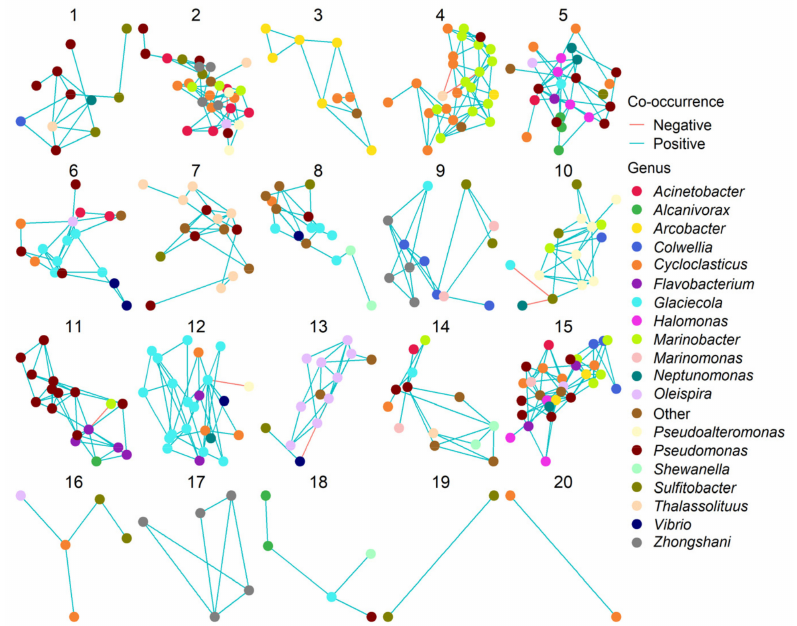
Figure 5. Network modules based on clustering of a SPIEC-EASI co-occurrence network formed of ASVs from bacterial genera associated with hydrocarbon degradation. Each point represents a single ASV, which are coloured according to their identity at the genus level (RDP classifier confidence >0.8). Blue edges represent positive co-occurrences between ASVs across the experiment, whereas red edges show negative co-occurrences.